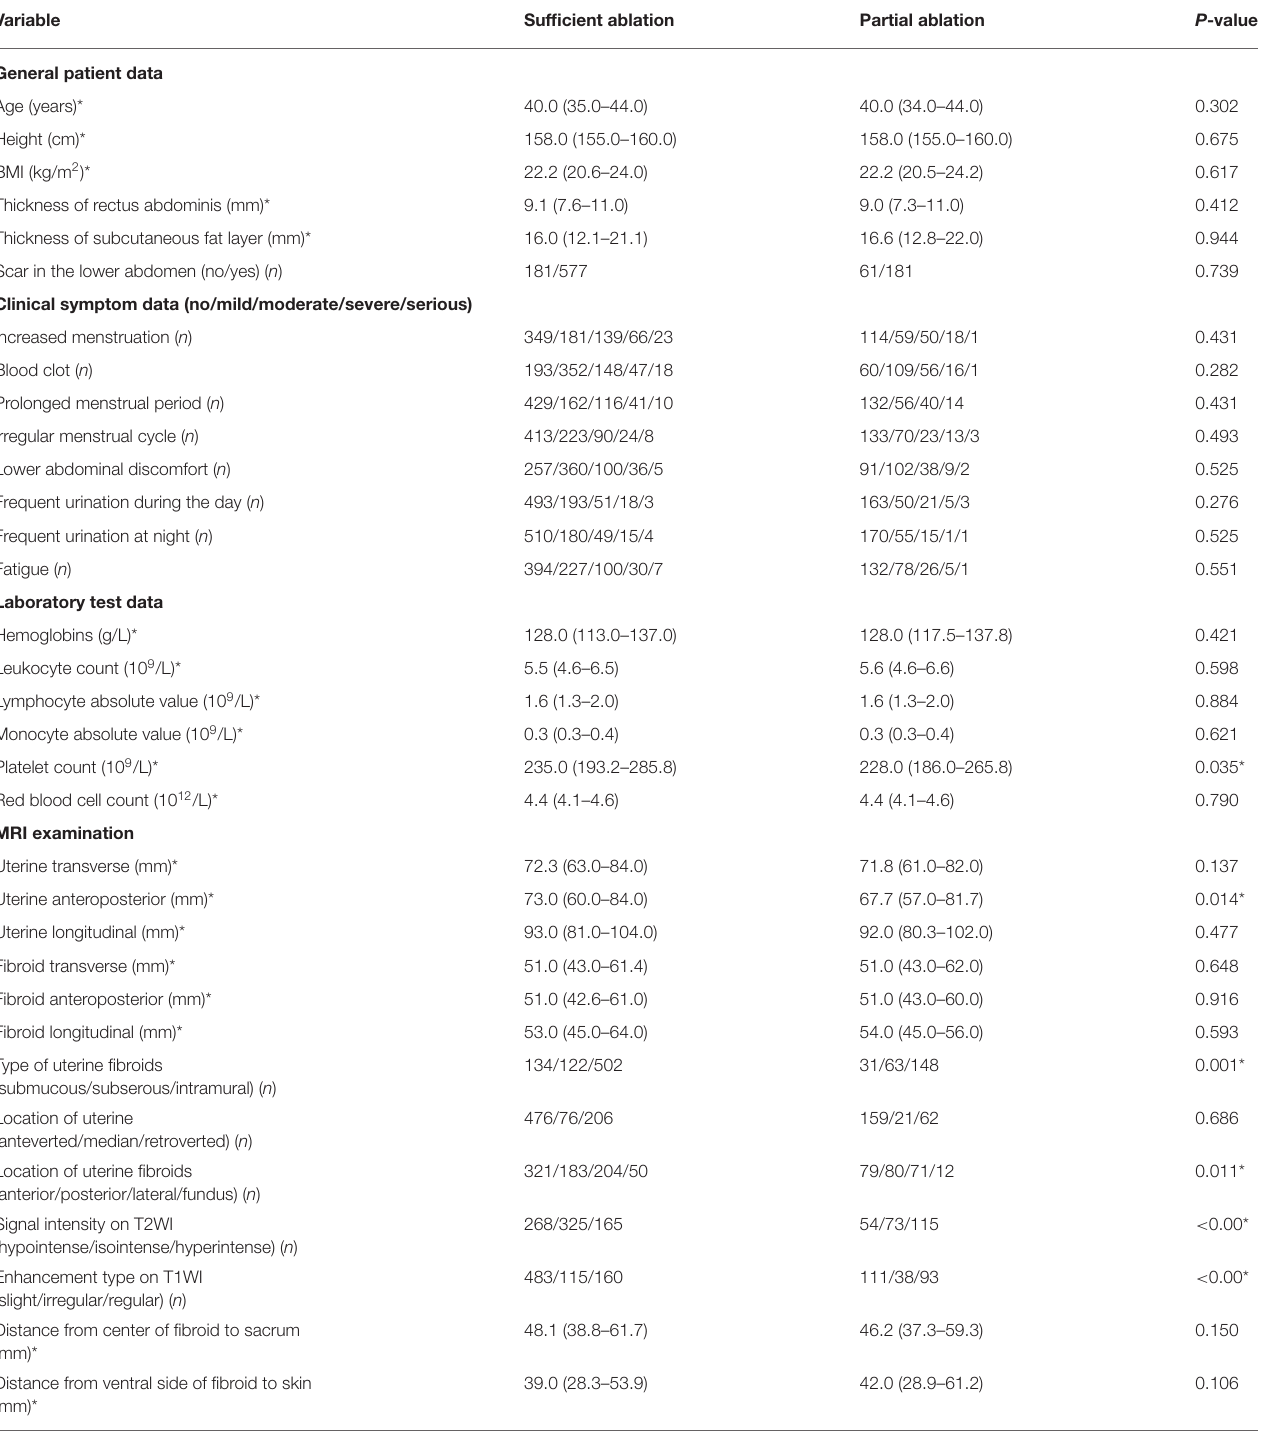
TABLE 2 | Comparison of characteristics between two